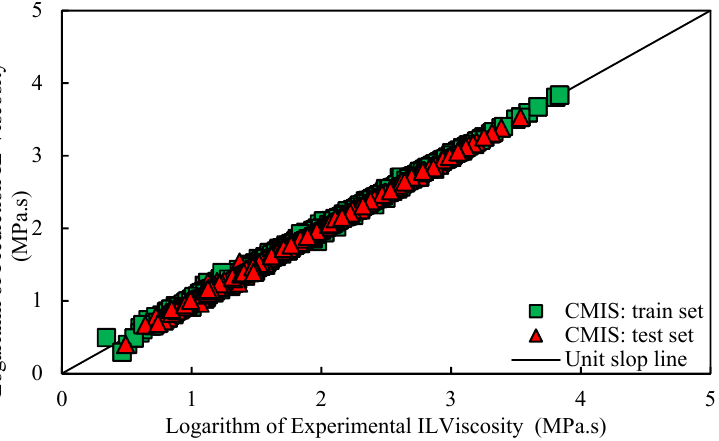
Figure 5. Logarithm of experimental viscosity data against predicted value based on Model (II) for CMIS model in this study.